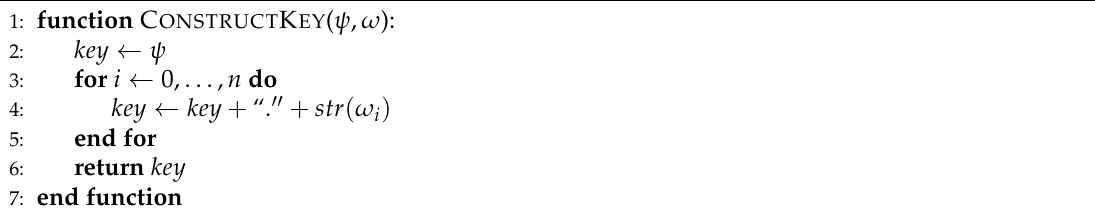
Algorithm 4 BLSK-NS weight inheritance key construction algorithm.